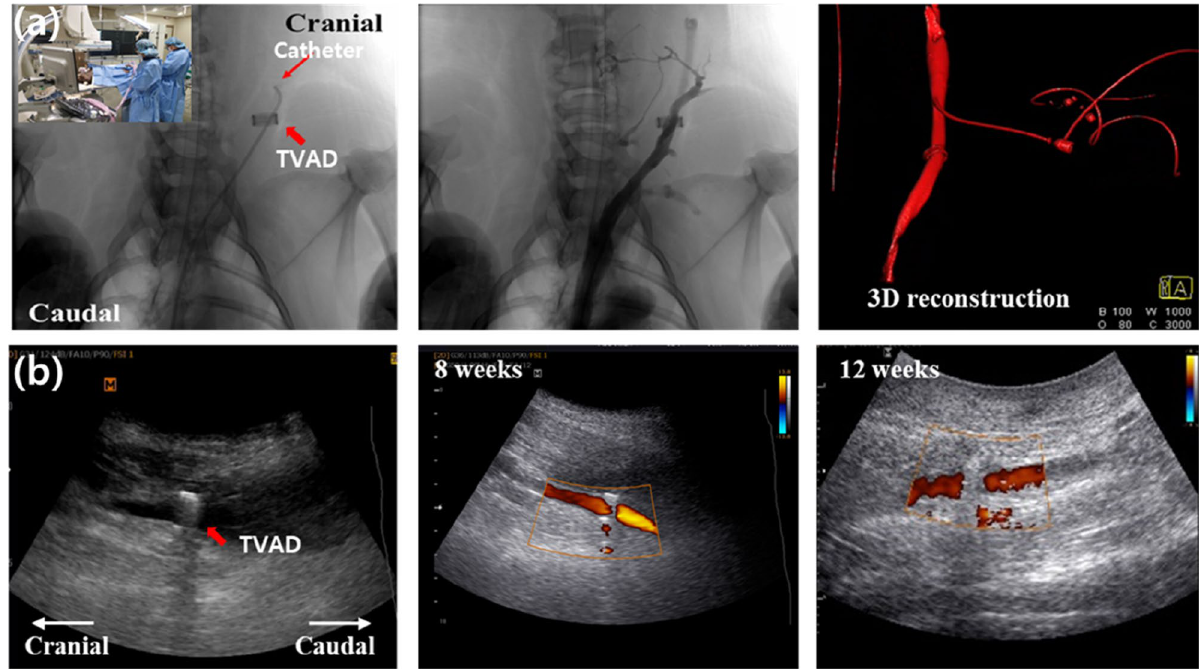
Figure 4. Representative angiographic and ultrasonographic images at 12 weeks after the anastomosis using titanium vascular anastomotic device (TVAD). ( a ) Conventional angiography demonstrated excellent patency of the anastomosis without stenosis caused by ischaemic change from the injured vasa recta. ( b ) Ultrasonographic examination also revealed a patent flow at the anastomotic site before and after the procedure, although it is limited to evaluating the flow at the anastomosis site that is hidden by posterior shadowing of the titanium coupler.